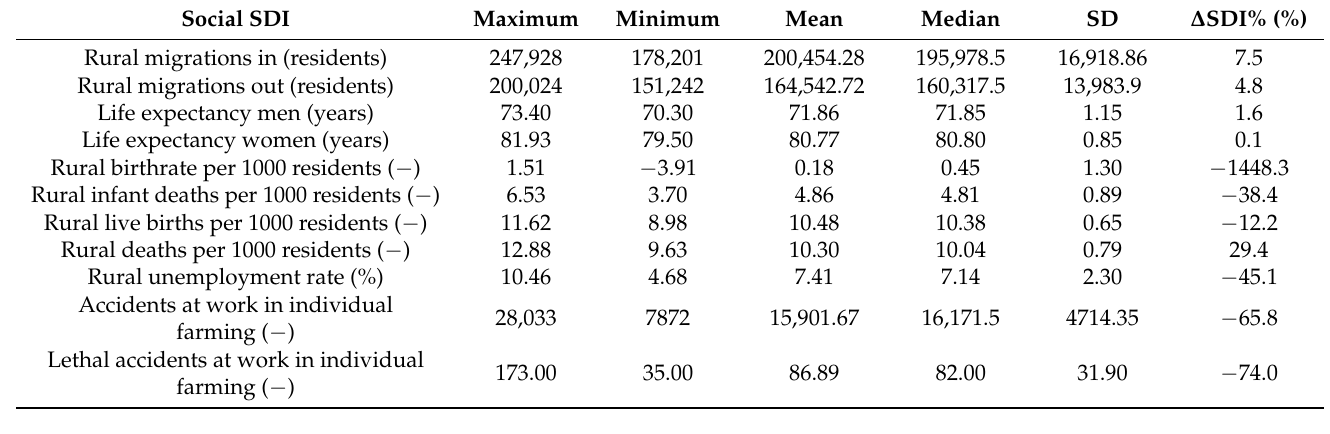
Table 3. Characteristics of social Sustainable Development Indicators used in the study.